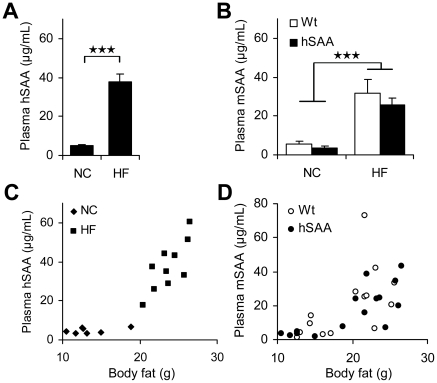
Analyses of SAA plasma levels.(A) Plasma levels of hSAA in NC (n = 7) compared to HF (n = 10) fed male animals. (B) Plasma levels of mSAA in NC (wild type (Wt) and hSAA; n = 7 and n = 6, respectively) and HF fed (Wt and hSAA; n = 8 and n = 9, respectively) animals. (C) Plasma levels of hSAA in relation to body fat quantified using DEXA analysis in transgenic male animals. (D) Plasma levels of mSAA in relation to body fat quantified using DEXA analysis in wild type (n = 15) and hSAA (n = 15) transgenic male animals.***, p<0.001. Values are given as mean ± SEM.